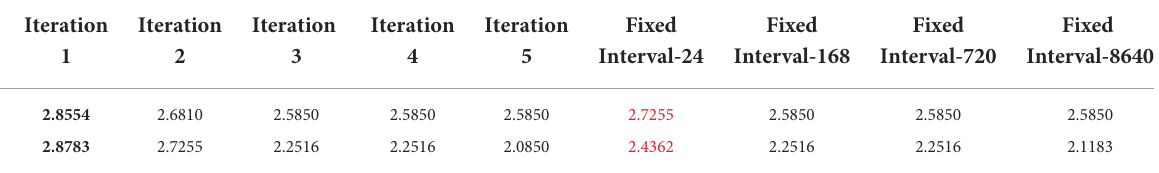
TABLE 3 The entropy of top-3 components in factors for the area and crime